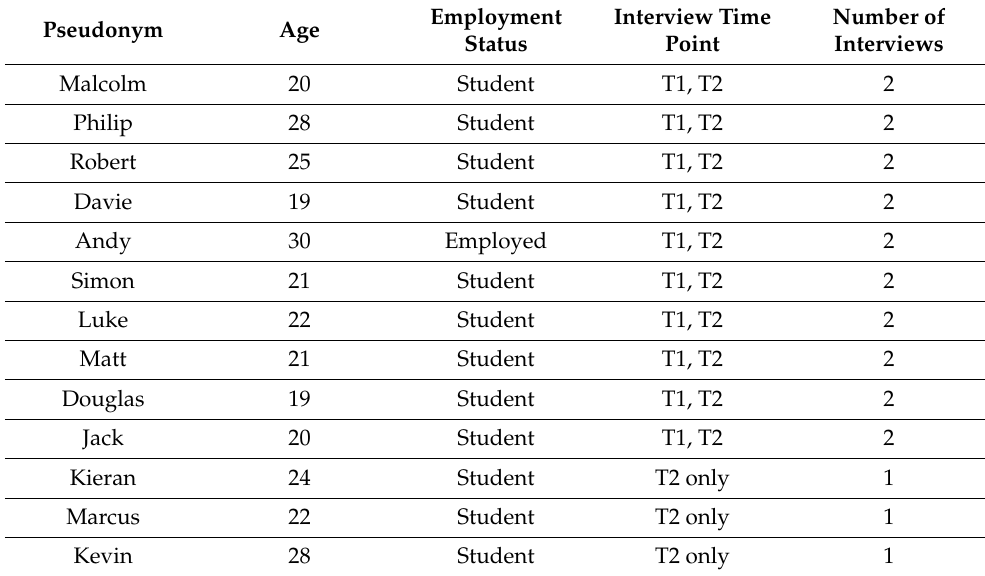
Table 1. Characteristics of the male study participants interviewed ( n =